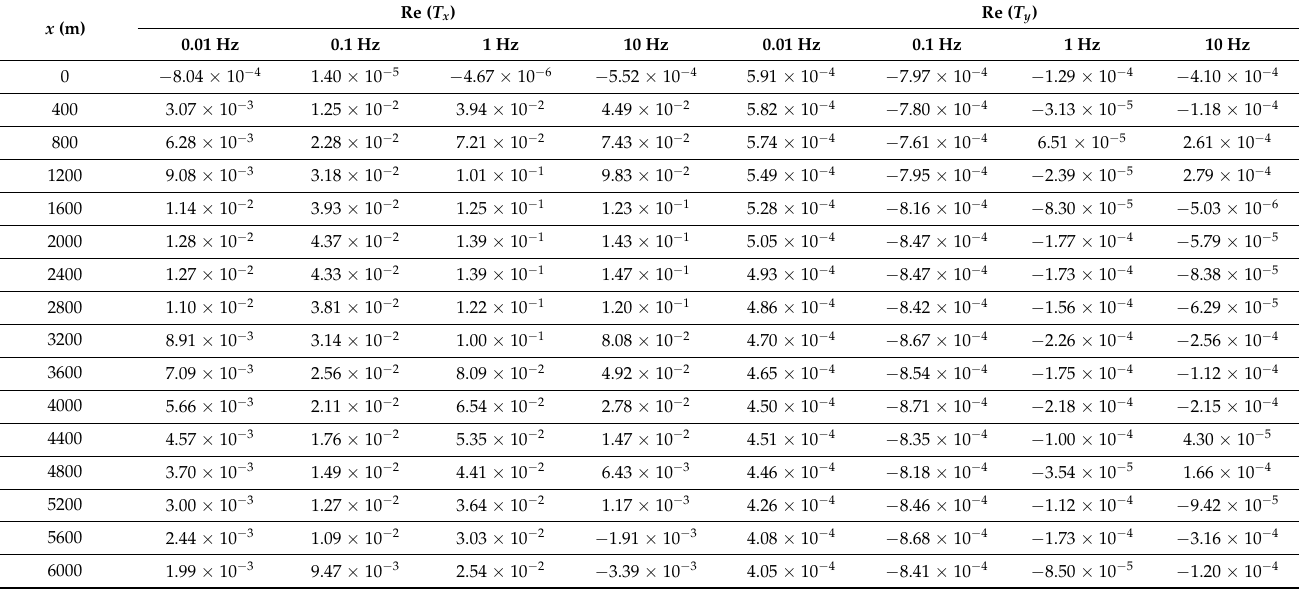
Table 5. The real parts of the tipper transfer function calculated by the FE method for Model 1, as shown in Table 3. The y -coordinate is 0